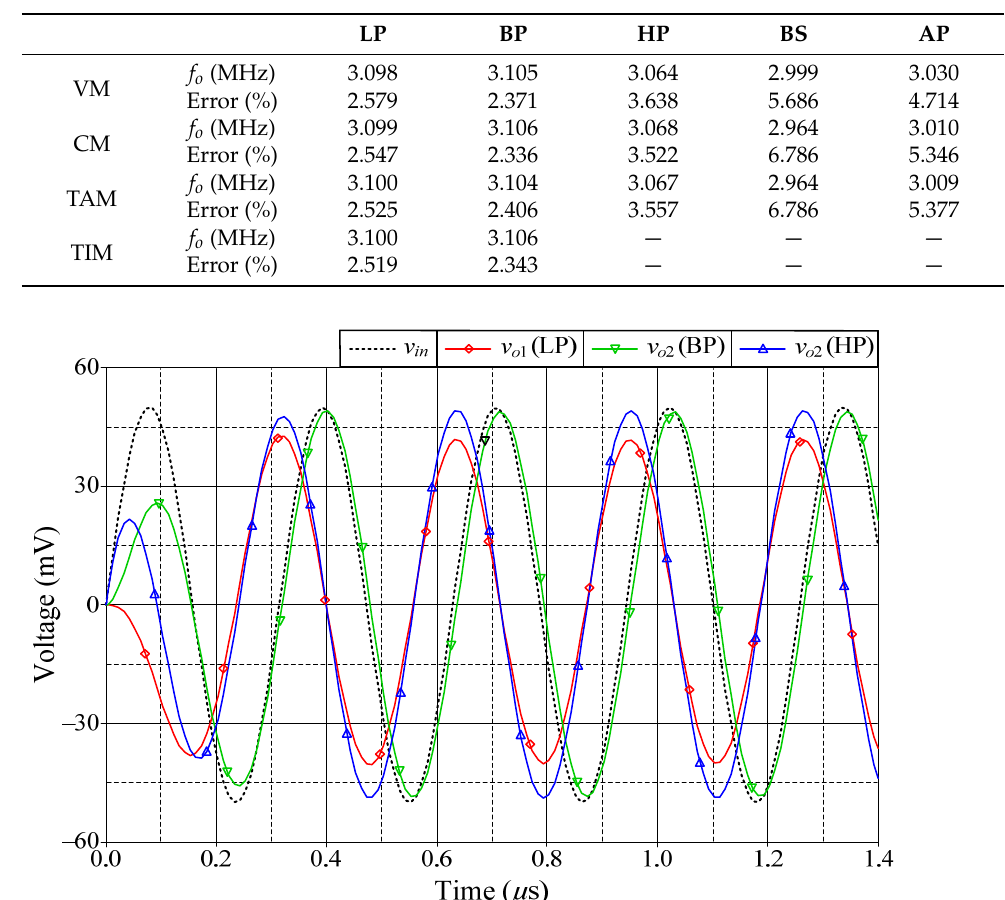
Figure 10. Time-domain responses of the LP, BP, and HP filters in VM.